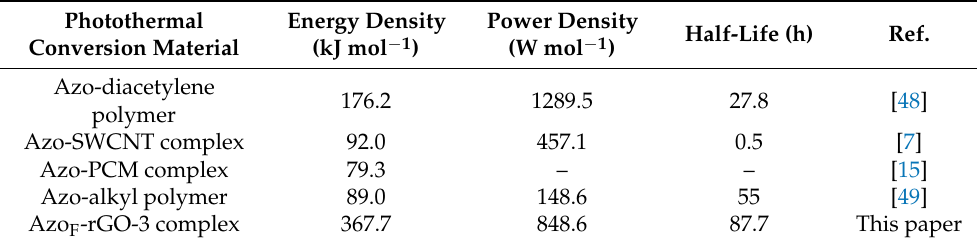
Figure S3: C1s region in XPS spectra of (a) rGO, (b) Azo F -rGO and (c) N1s region in XPS spectra, Figure S4: Raman spectra, Figure S5: Time-evolved absorption spectra of Azo F and Figure S6: UV- Vis absorption spectra of Azo F -rGO powder at room temperature (25 °C).